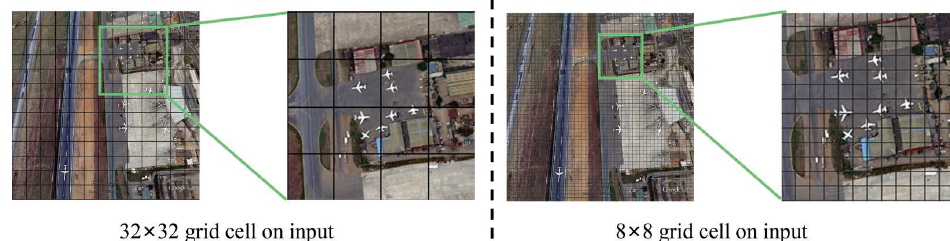
Figure 3. Different grid cells on